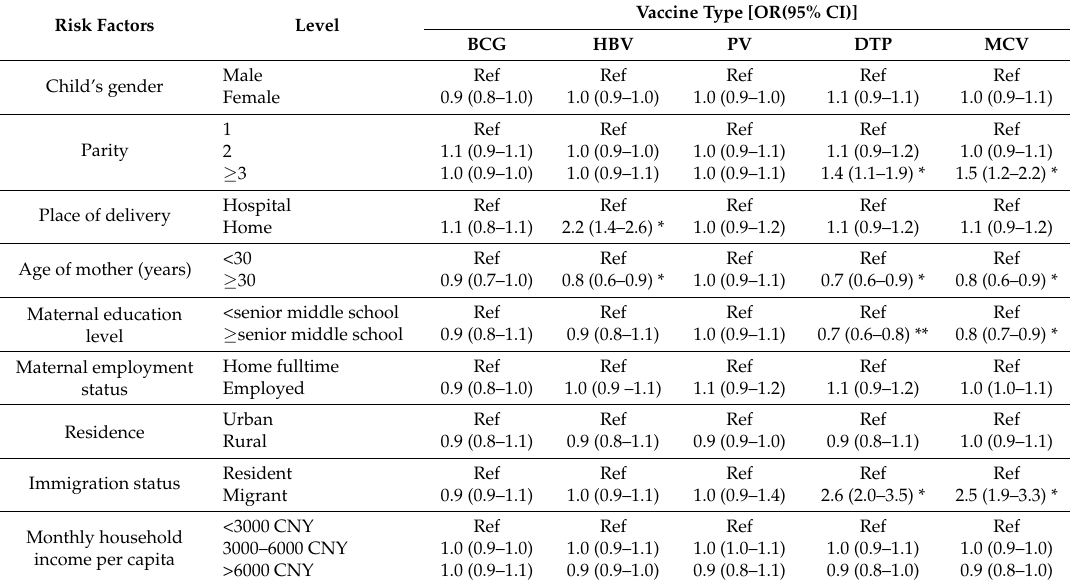
Table 4. Logistic regression model results on the risk factors of maternal recall bias across vaccine